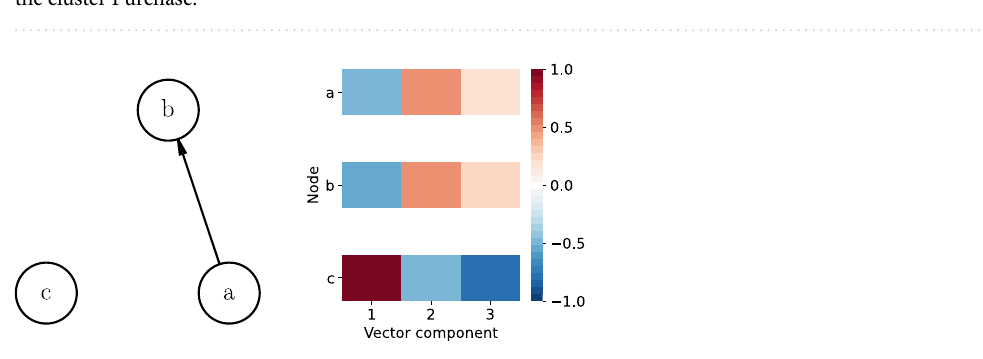
Figure 8. Visualization of vectors x i grouped in clusters. On the y-axis we display the name of the clusters and the x-axis shows the vector element with k = 8 . For each cluster we show 10 vectors x i that belong to that cluster. Vectors x i that belong to the same cluster are similar while, for example, the cluster Collections is different from the cluster Purchase.